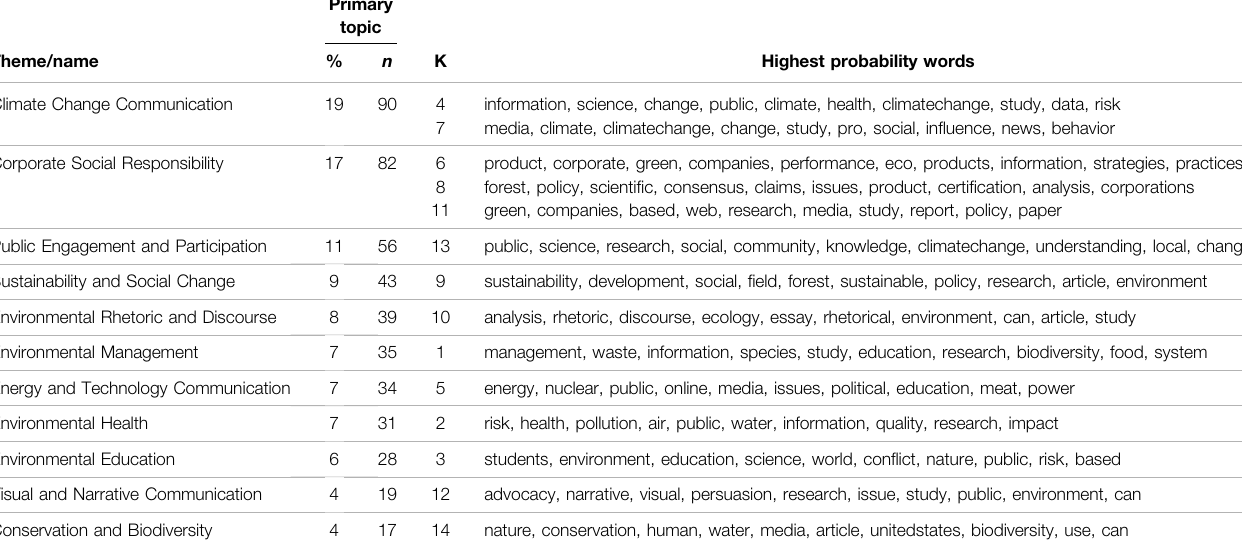
TABLE 4 | Themes and topics from STM, total proportion of abstracts with each primary topic, and highest probability words for each topic. Primary